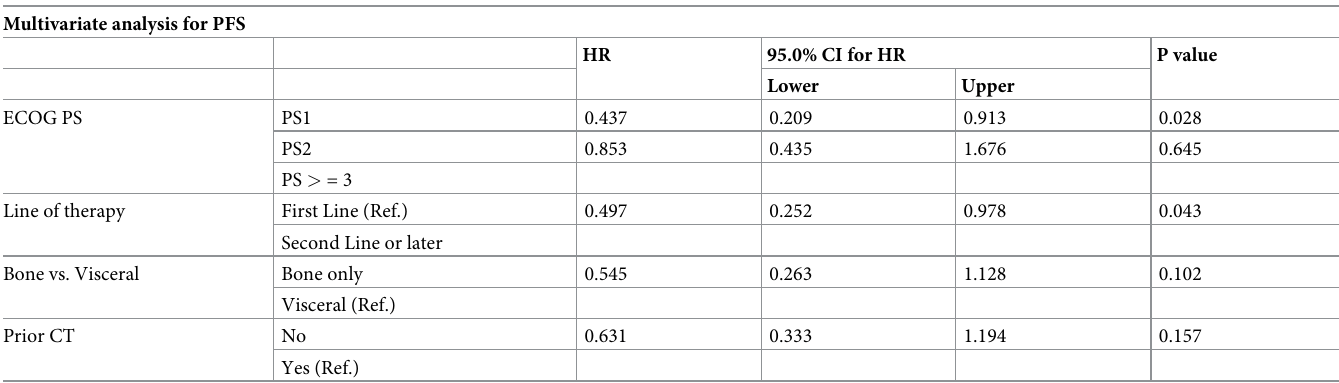
Table 5. Multivariable analysis of progression-free survival. Multivariate analysis for PFS